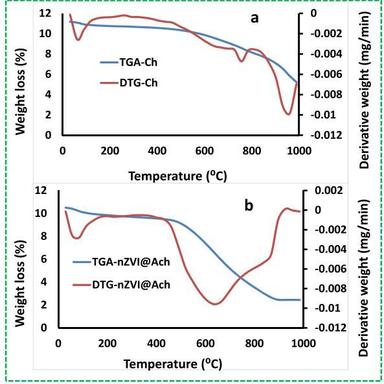
TGA and DTG profiles of (a) ACh and (b) nZVI@ACh.